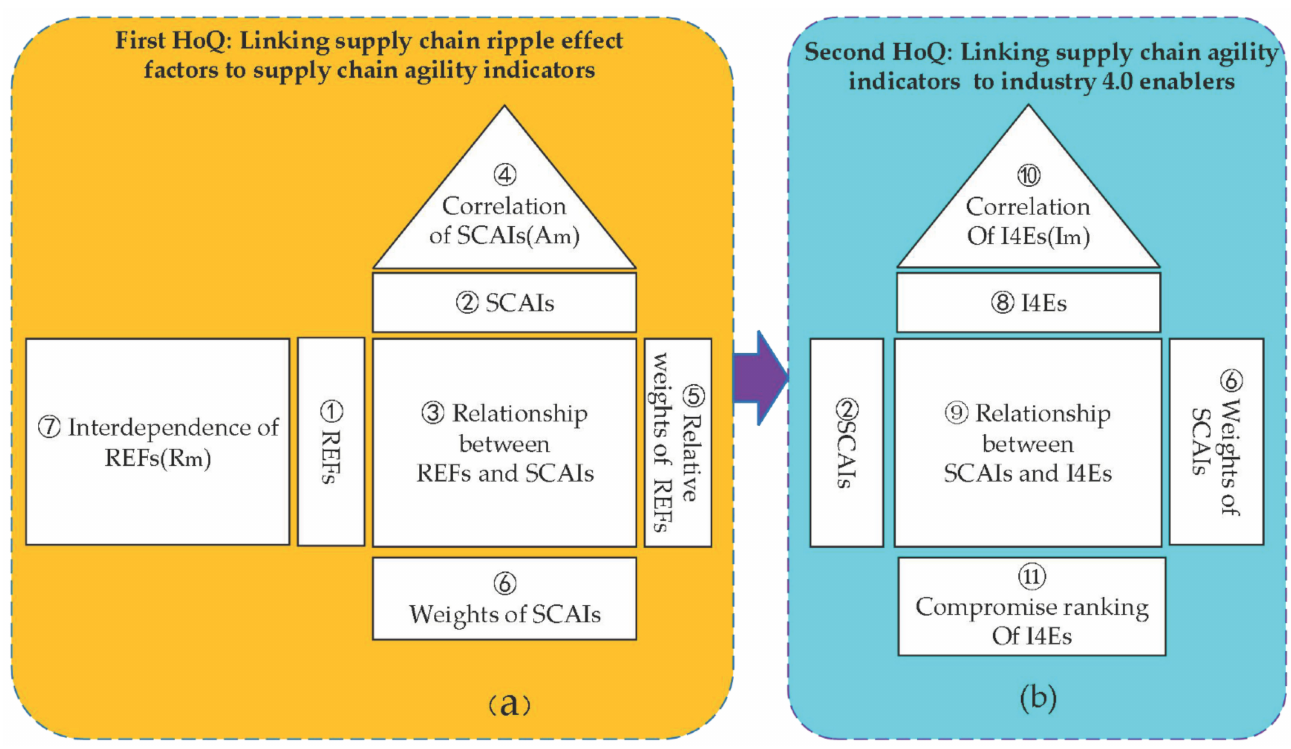
Figure 1. Structure of the two-phase houses of quality (HoQs). ( a ) First HoQ; ( b ) Second